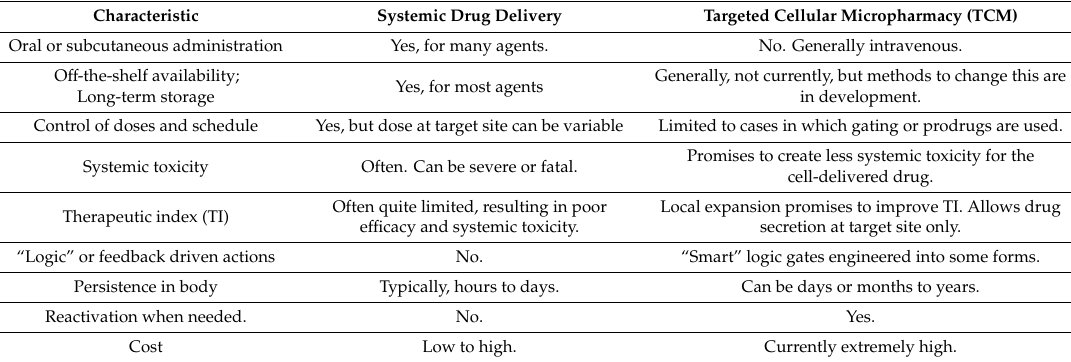
Table 4. Comparisons of the local delivery of drugs by TCM vs. systemic drug